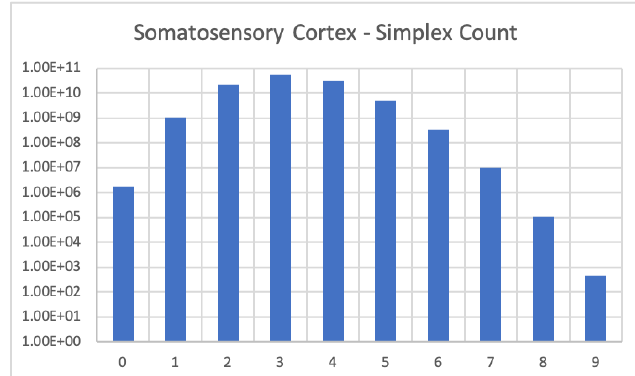
Figure 2. Cell count in the Blue Brain reconstruction of the somatosensory cortex. Computation was run on an HPC cluster using 256 CPUs, required 55.69 GB of memory and took 7.5 h to complete.